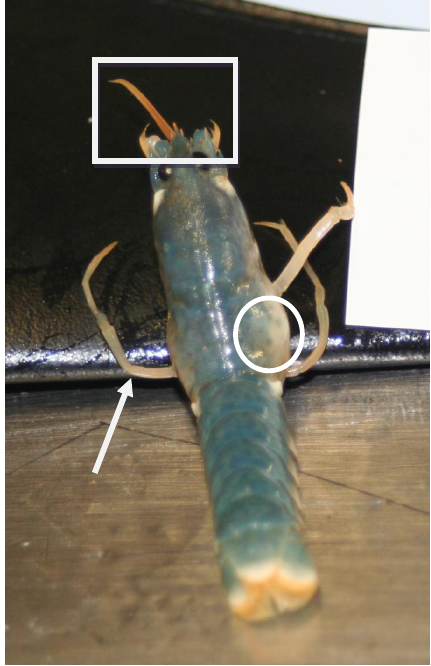
Fig. 10. Homarus gammarus juvenile, one year of age, exposed to pH < 8.1 since hatch displaying deformities as puffy carapace Figure 10. (circle), stiff/twisted walking legs (arrow) and lacking antennas